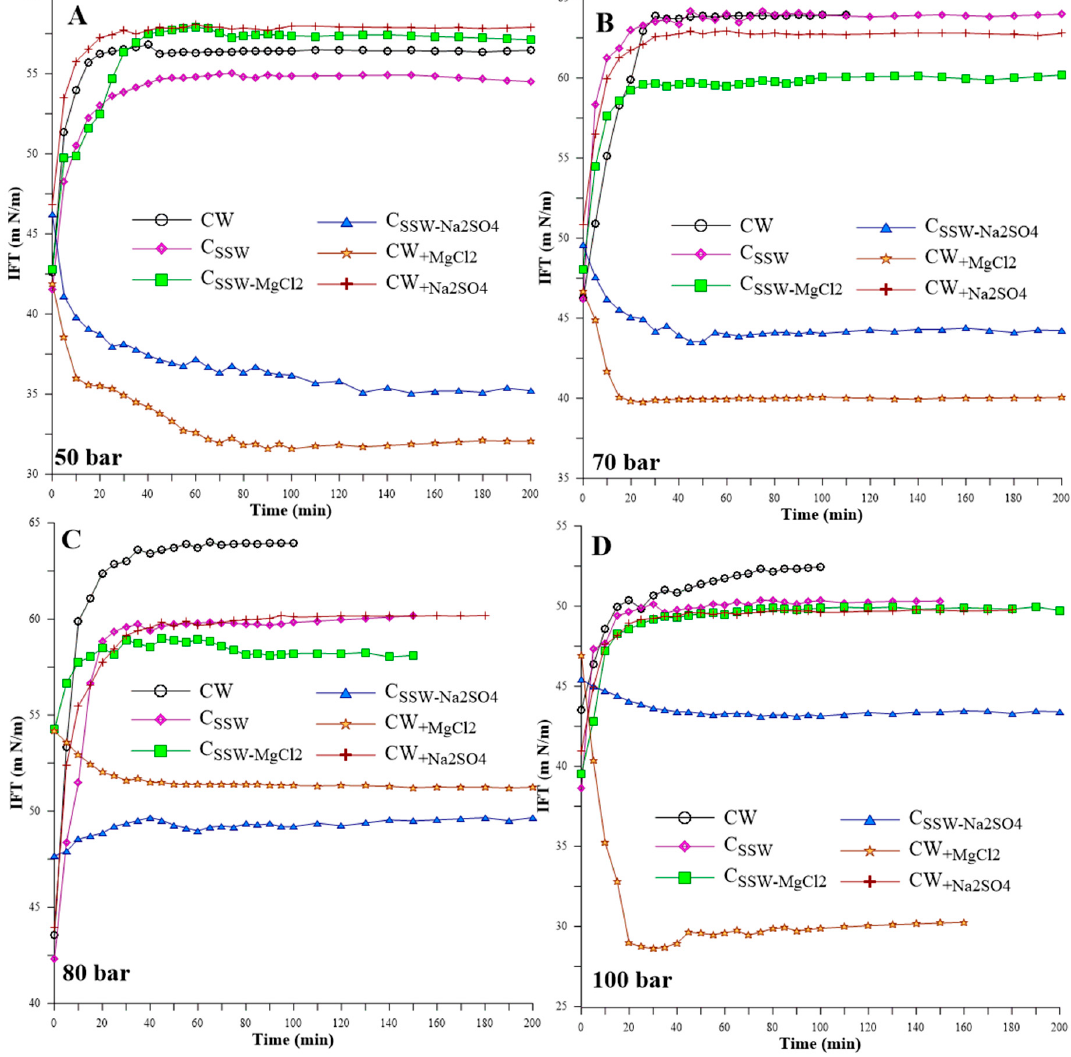
Figure 6. Dynamic changes in the CB/n-decane IFT for different brine compositions at 50 bar ( a ), 70 bar ( b ), 80 bar ( c ), and 100 bar ( d ) at 45 °C. 70 bar ( b ), 80 bar ( c ), and 100 bar ( d ) at 45 ◦